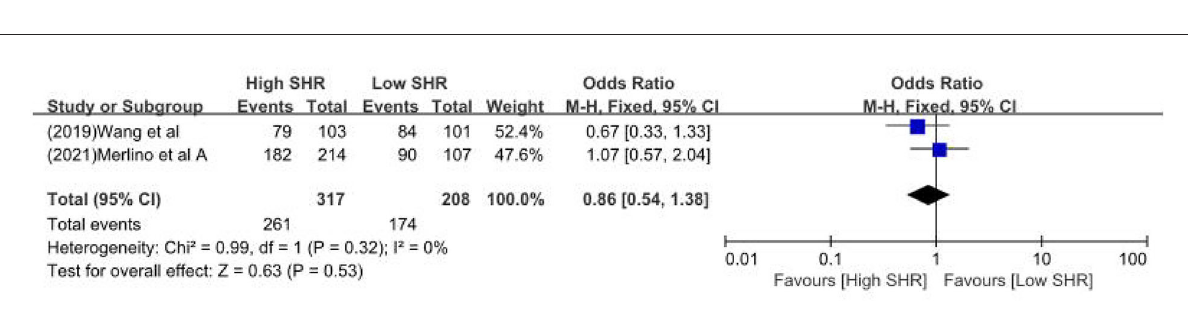
FIGURE5 The recanalization rate between high SHR and low SHR